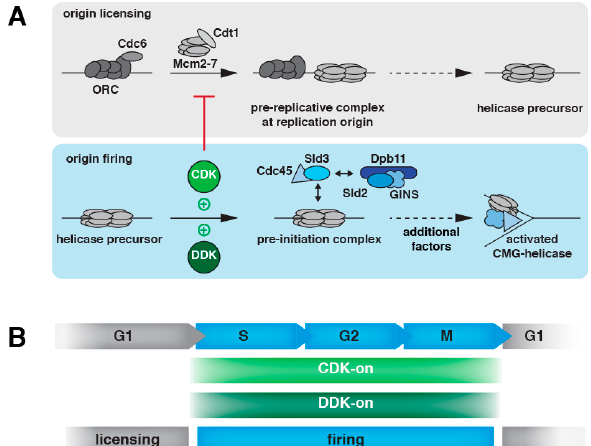
Figure 1. Two-step mechanism of DNA replication initiation. ( A ) Inactive helicase precursors are loaded during origin licensing (upper panel); CDK and DDK promote activation of these precursors to form active CMG helicases during origin firing (lower panel). In addition to the depicted factors, origin firing and helicase activation involve Sld7, DNA polymerase ε , and Mcm10, which are indicated as additional factors. ( B ) Changing activity of CDK and DDK couples licensing and firing strictly to distinct phases of the cell